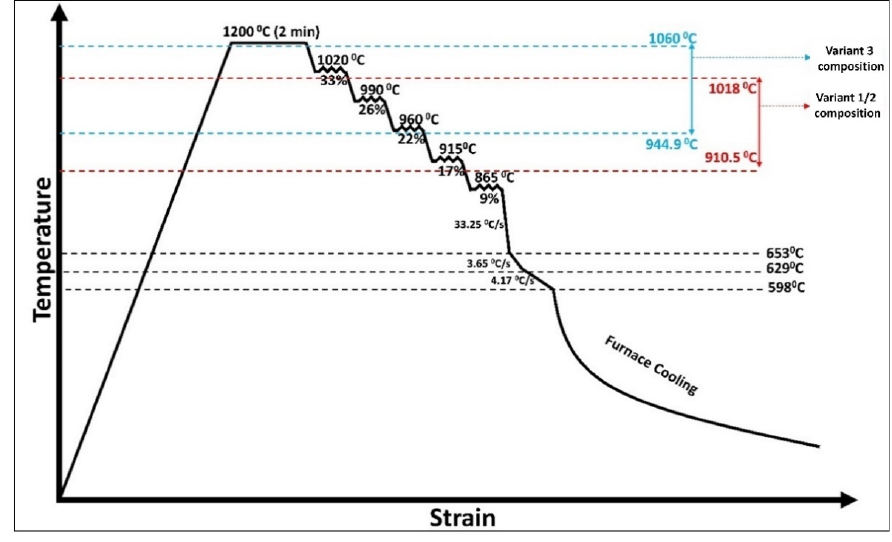
Figure 10. Temperature–strain profile used for plane strain rolling in the Gleeble HDS-V40 for the Variant 1/2 composition and Variant 3 composition steels with their corresponding TNR temperature range.